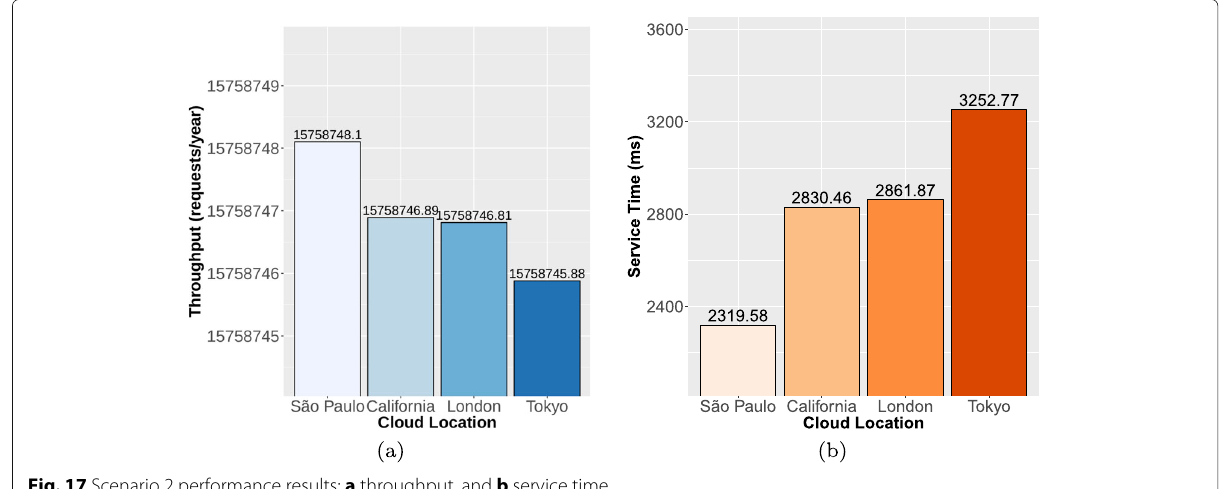
Fig. 17 Scenario 2 performance results: a throughput, and b service time